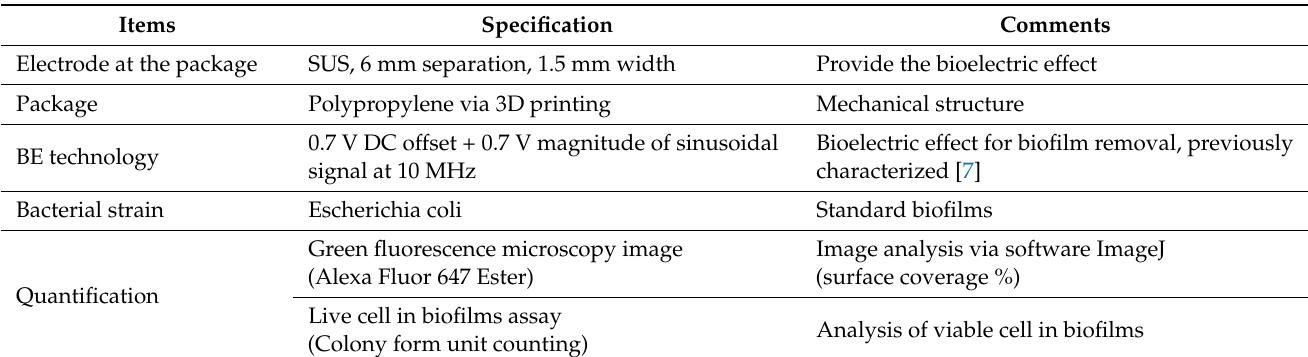
Table 1. Summary of the testing package and analysis